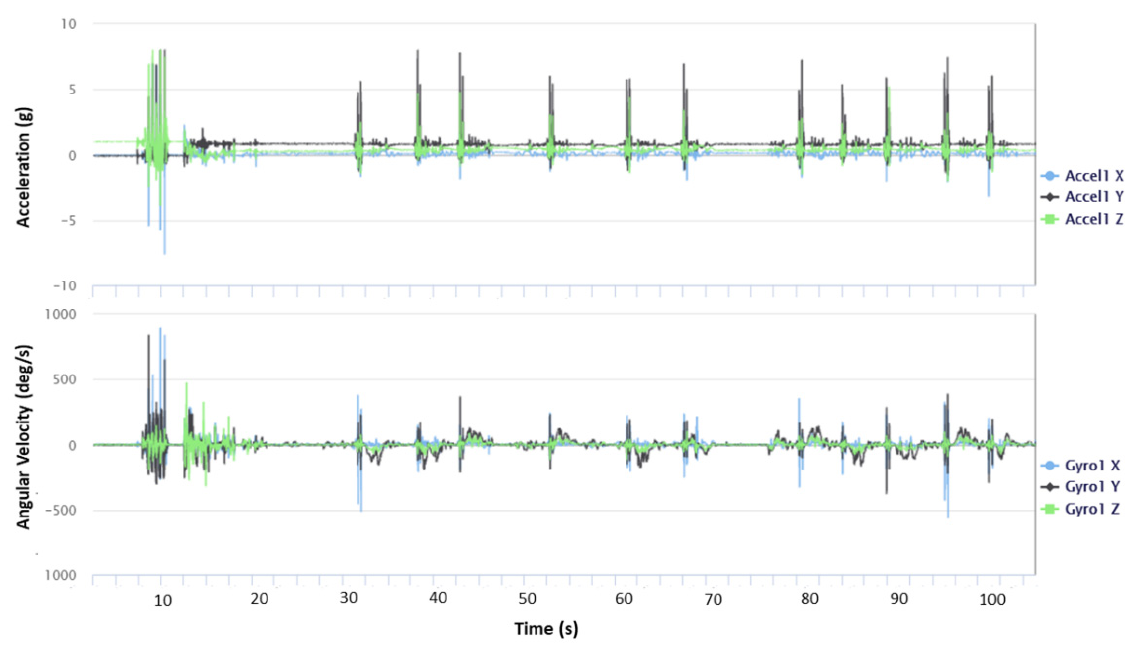
Figure 4. Signals recorded by the IMU placed on the sacrum, displayed in the RKS. The signals are the 3D accelerations ( top ) and the 3D angular velocities ( bottom ).